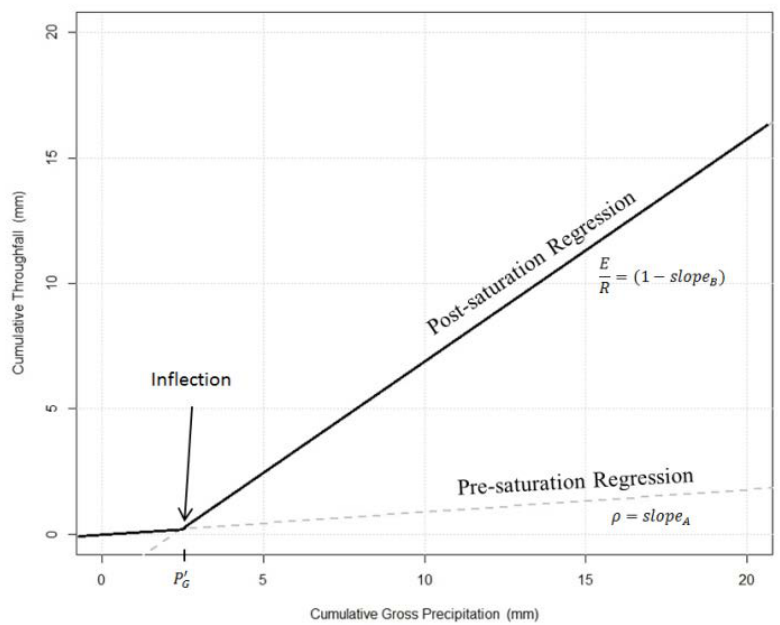
Figure 3. Graphic method for Gash model parameterization.